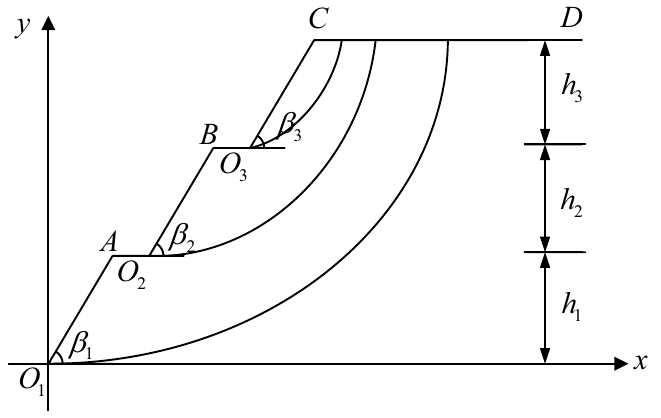
Figure 2. Schematic diagram of the search model for the sliding surface of a multi-level loess